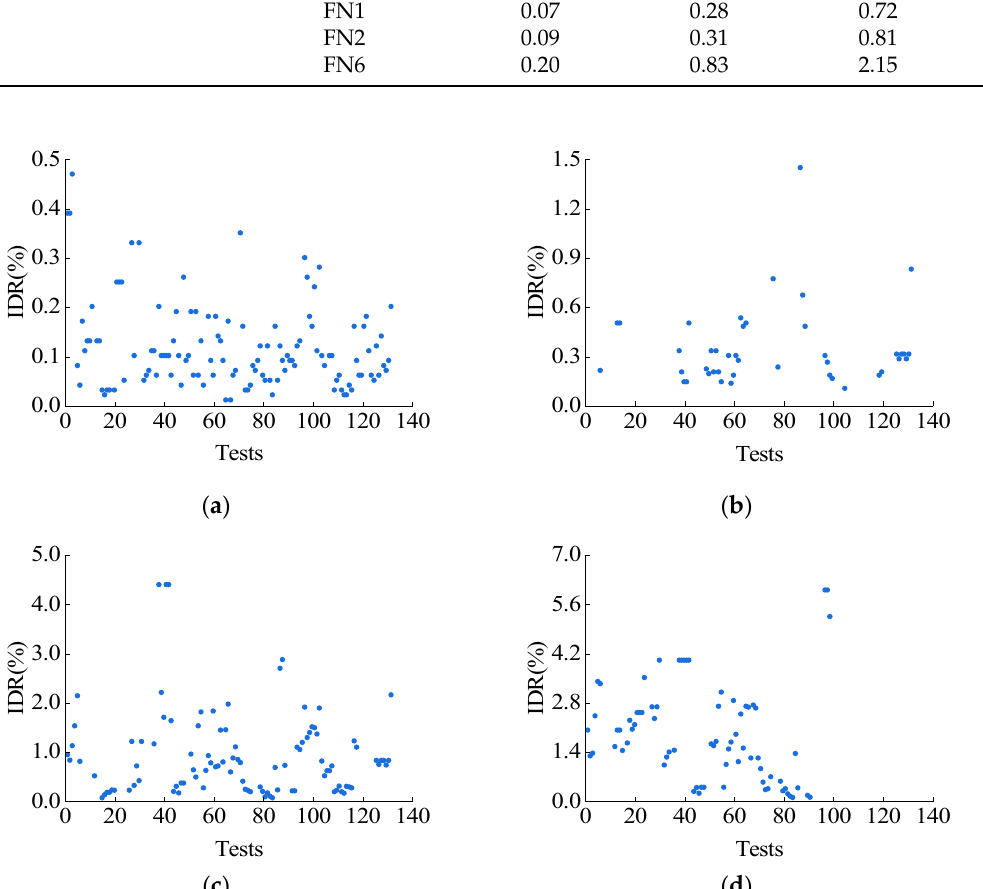
Figure 2. Scatter diagram of IDR at each DS. ( a ) DS1; ( b ) DS2; ( c ) DS3; ( d ) DS4.